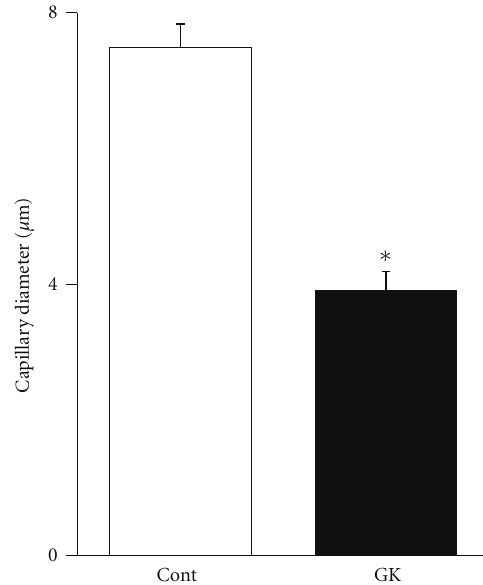
Figure 5: The mean capillary diameter in the soleus muscle of the Cont and GK rats. The capillary diameter in the soleus muscle of the Cont rats was thicker than that in the GK